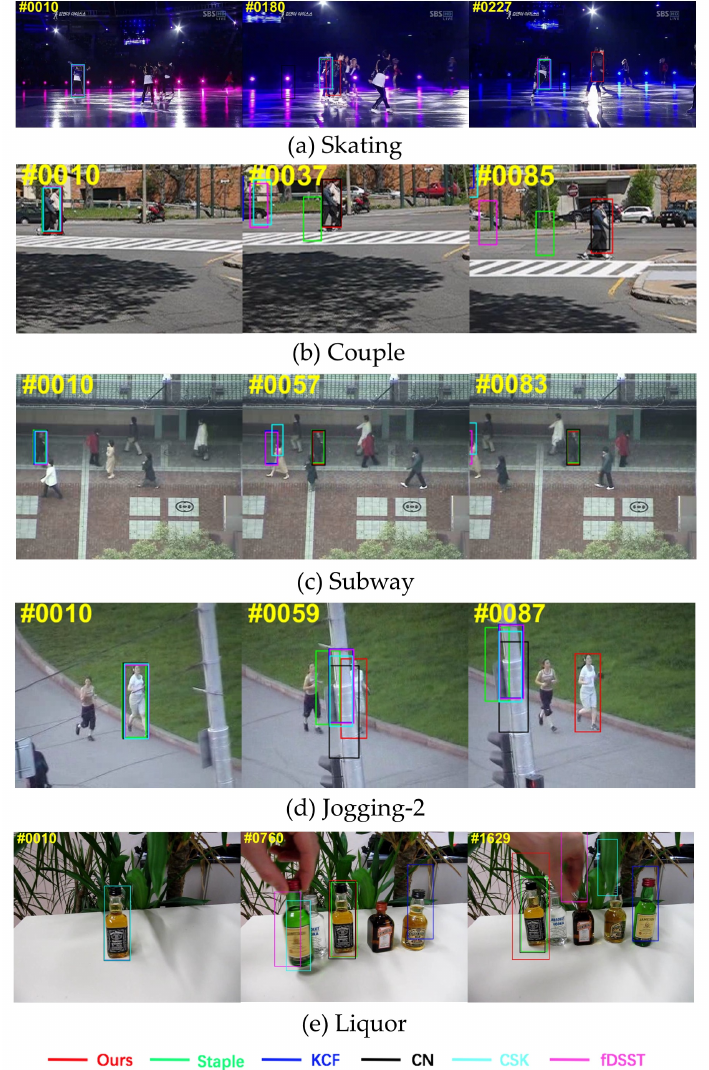
Figure 5. The visualization of comparison results of our proposed tracker and other existing trackers on five challenging sequences, i.e, ( a ) Skating, ( b ) Couple, ( c ) Subway, ( d ) Jogging-2, ( e )